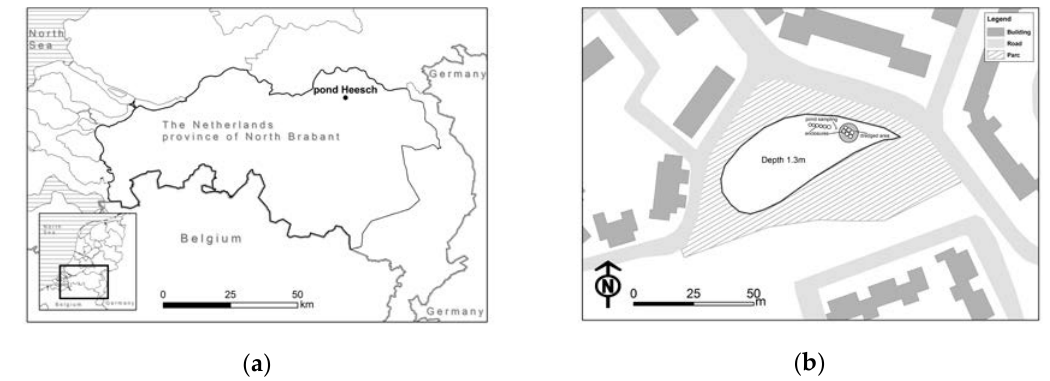
Figure 1. Location of Heesch Pond in the province of North Brabant ( a ); a more detailed schematic overview of the pond including the location of the enclosures in the pond ( b ).